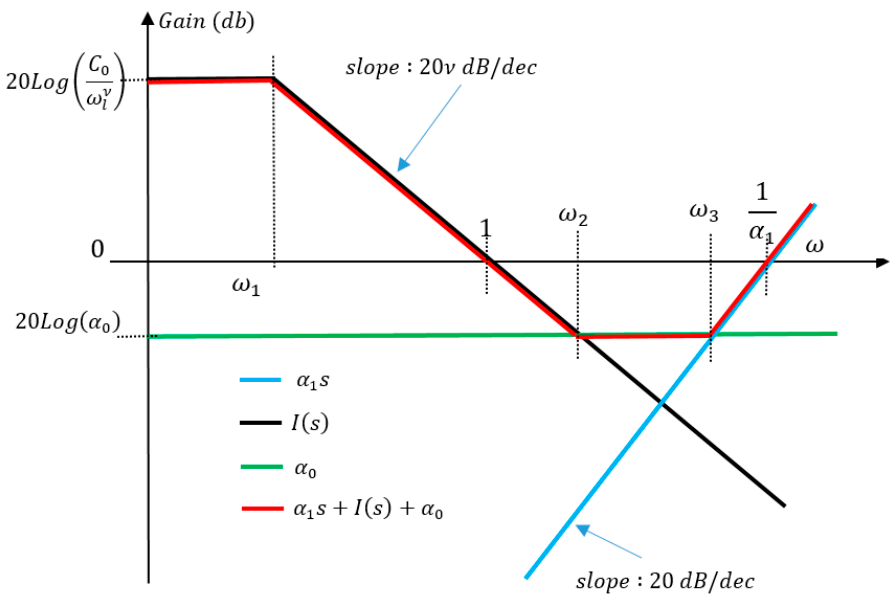
Figure 3. Impact of parameters ν , α 0 , and α 1 on the gain of Model (14) denominator.